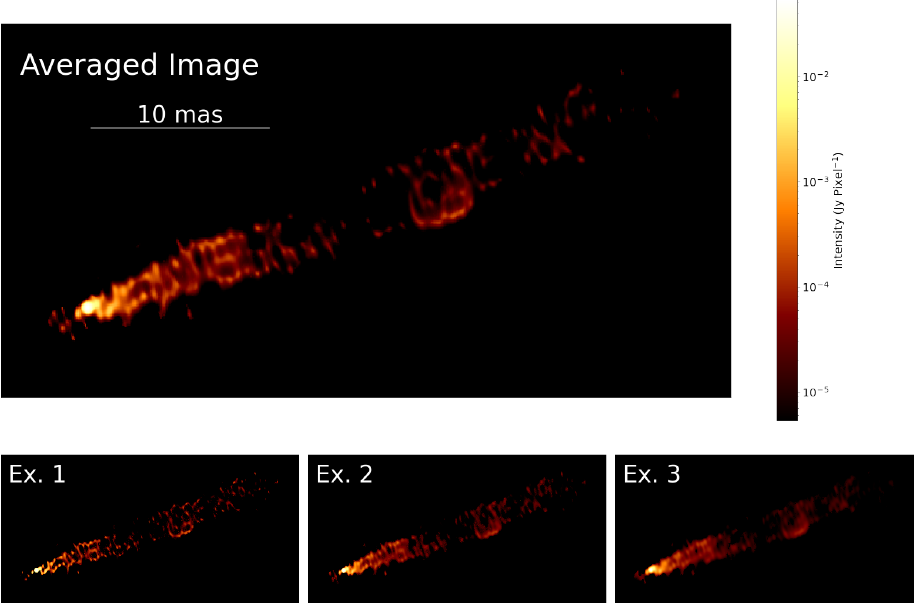
Figure 3. The top panel shows the averaged image of the final 48 images. The bottom panel shows 3 images taken from a total of 48 images as examples to see how much difference there is between the selected 48